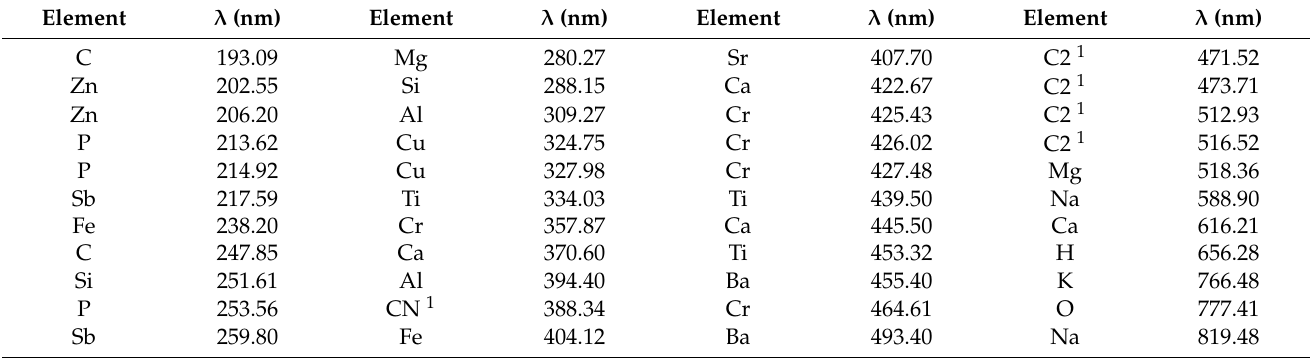
Table 2. Element wavelengths and molecular bands employed for principal component factor